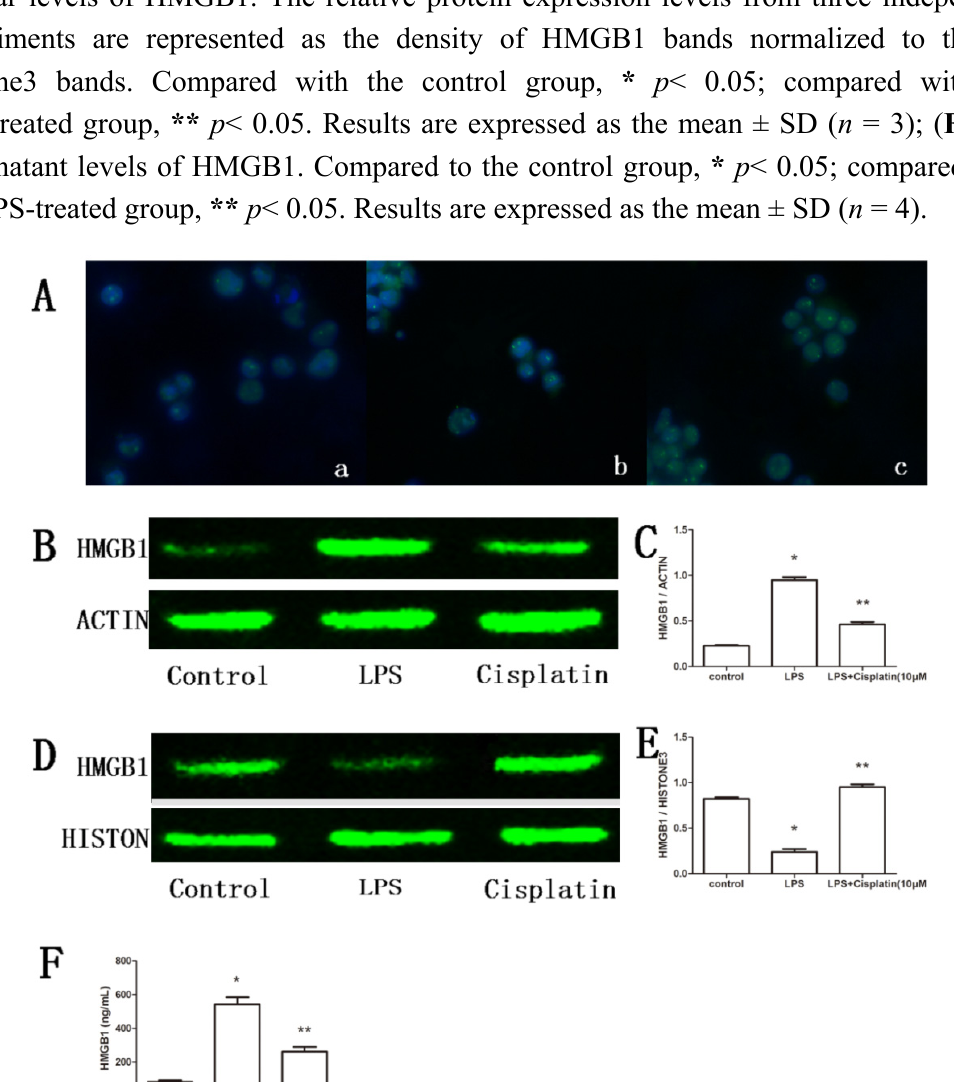
Figure 3. Effect of cisplatin on HMGB1in macrophage-like cells. ( A ) Immunofluorescence analysis of HMGB1. HMGB1 was stained green, and nuclei were stained blue, (original magnification ×400). a: Control group, HMGB1 (green fluorescence) was localized mainly in the nucleus; b: LPS-treated group, HMGB1 was localized mainly in the cytoplasm and extracellular matrix; c: LPS+cisplatin-treated group, although HMGB1 present both in nucleus and extracellular matrix, HMGB1 mainly existed in the nucleus; ( B ) Cytoplasmic levels of HMGB1 detected by Western blot analysis. β -actin was probed as an additional loading control. Control: control group, LPS: LPS-treated group, CISPLATIN: LPS + cisplatin-treated group; ( C ) Semi-quantification of cytoplasmic levels of HMGB1. The relative protein expression levels from three independent experiments are represented as